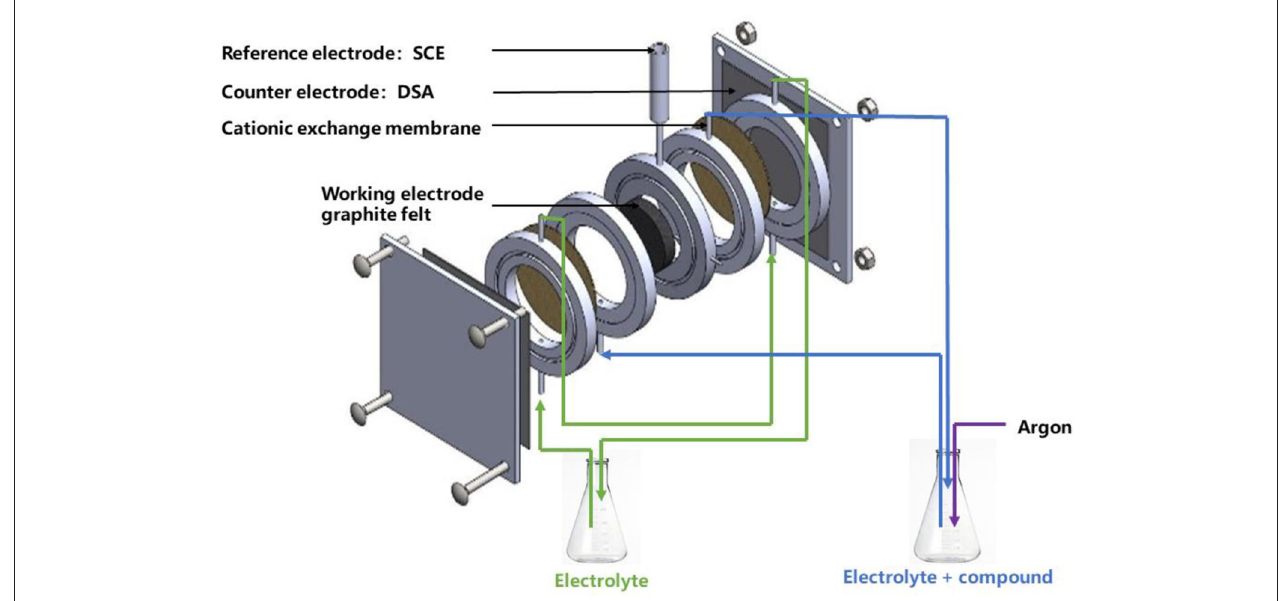
FIGURE 1 | Flow electrochemical